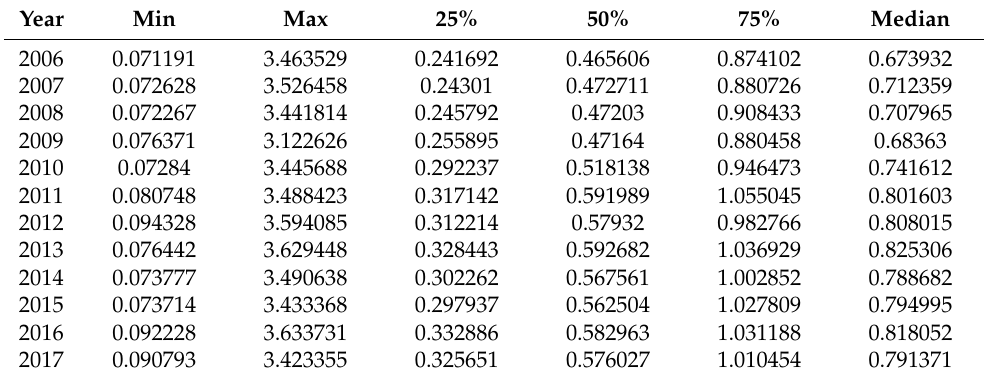
Table 1. Distribution of deviation degrees of energy input in China.